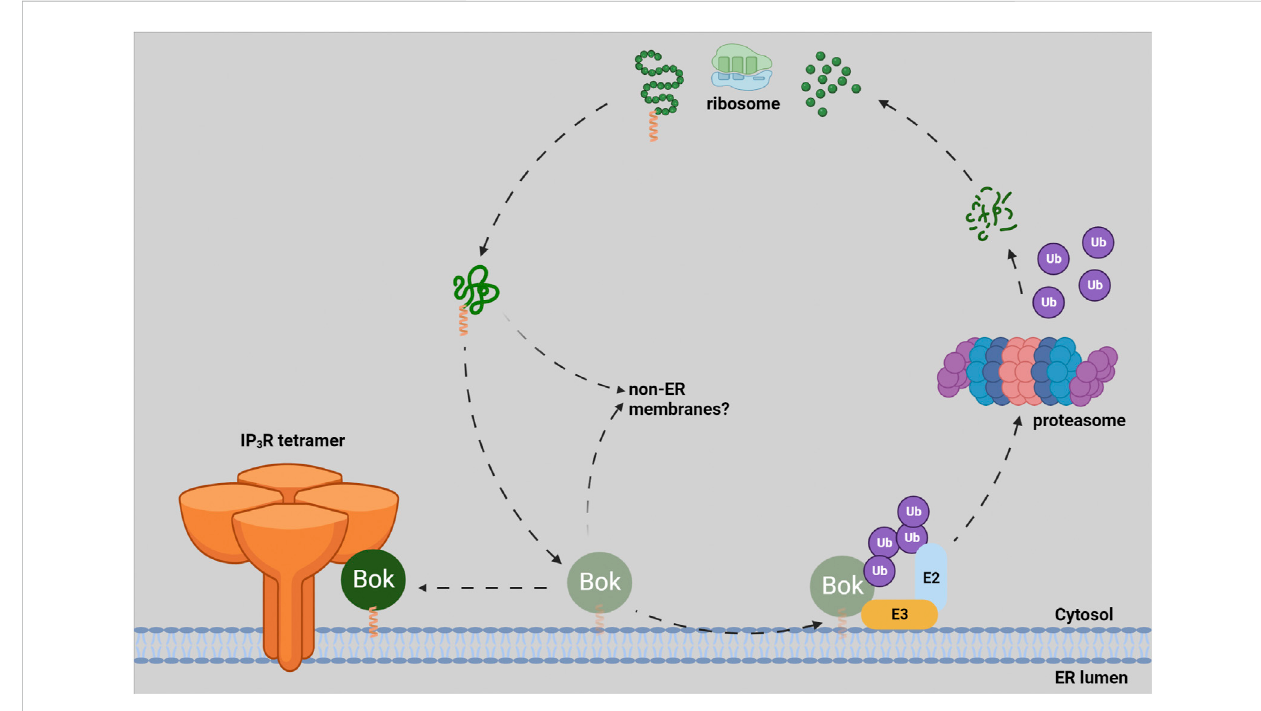
FIGURE 1 Lifecycle of endogenous Bok. Newly synthesized Bok, with its C-terminal TA (green polypeptide with orange helical TMD) emerges from the ribosomeand ischaperoned byan unknown mechanism to theERmembrane. Once intheER, Bokbindsto IP 3 Rsand becomesstable.IfBokisunableto locate IP 3 Rs (e.g., in IP 3 R KO cells), Bok is unstable and rapidly degraded by the UPP. The ubiquitin-conjugating enzyme (E2) and the ubiquitin-ligase enzyme (E3) responsible for Bok ubiquitination (and subsequent delivery to the proteasome) are currently not de fi ned (Bonzerato et al., 2022). It is possible that some Bok inserts into non-ER membranes, but in those cases, Bok would be